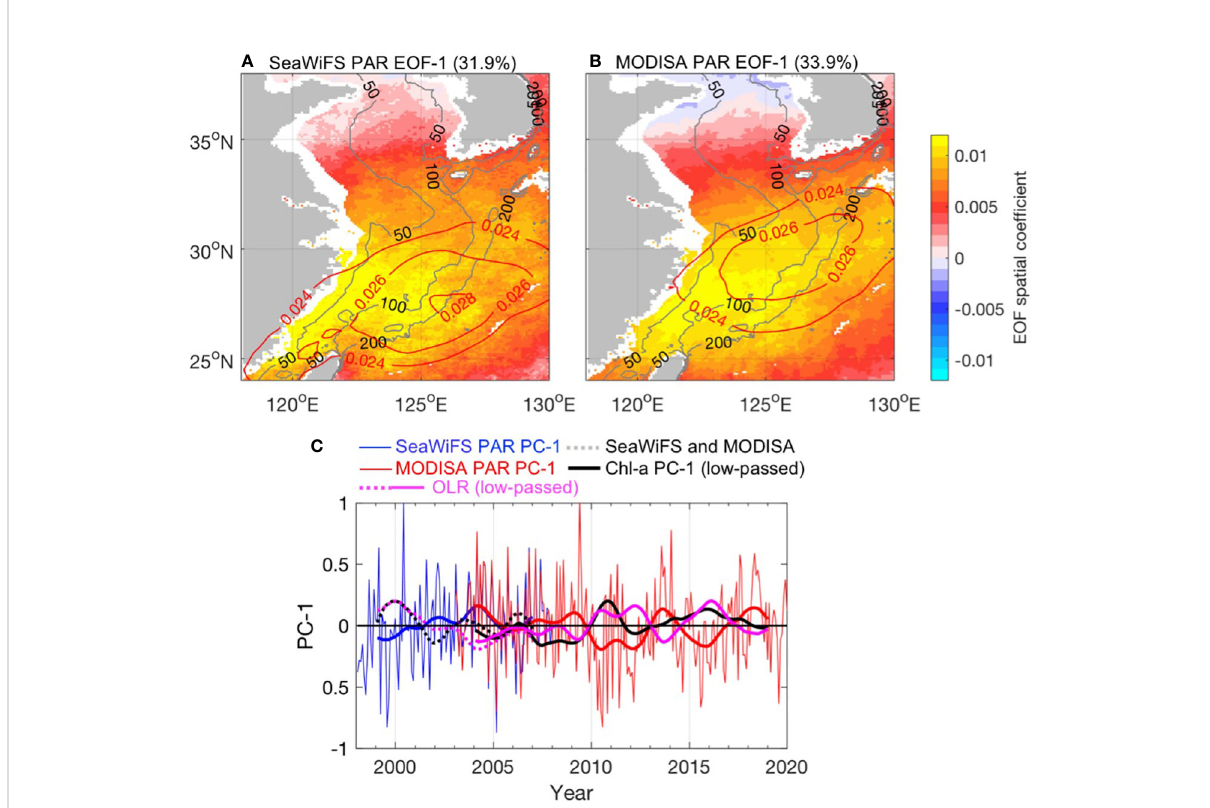
FIGURE 7 (A, B) Spatial coef fi cients of the fi rst EOF mode for the SeaWiFS and MODISA anomalous Chl -a and OLR fi elds, respectively. The overlapped red contour lines denote the eigenvector of the fi rst EOF mode of the OLR, which explains 49.7% and 52.3% of the total variance in the SeaWiFS and MODISA periods, respectively. The gray contour lines in each map denote the 50-, 100-, and 200-m isobaths. (C) Normalized EOF temporal amplitude (PC) for the SeaWiFS (blue) and MODISA (red) PAR. The thick blue and red lines denote 12-month low-pass PC-1. The black dashed and thick lines indicate the 12-month low-pass PC-1 for Chl -a during the SeaWiFS and MODISA periods, respectively. The pink lines indicate the low-pass PC-1 for OLR during the SeaWiFS and MODISA periods,